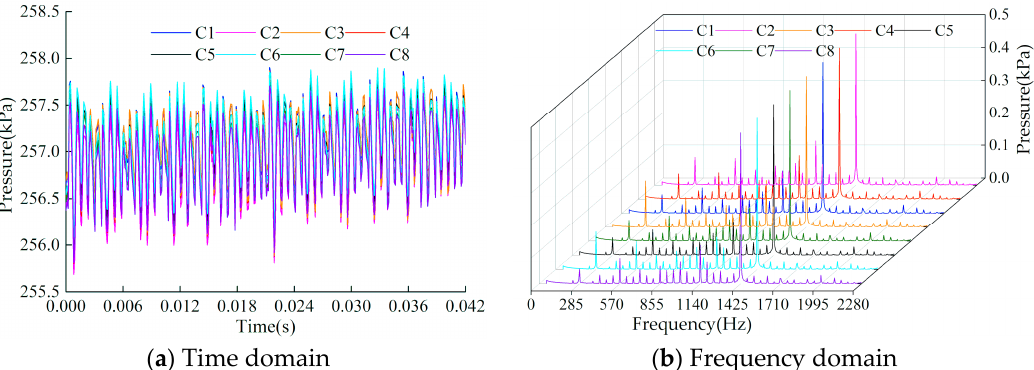
Figure 22. The time and frequency domain diagrams of pressure fluctuation for monitoring points in the pump chamber.